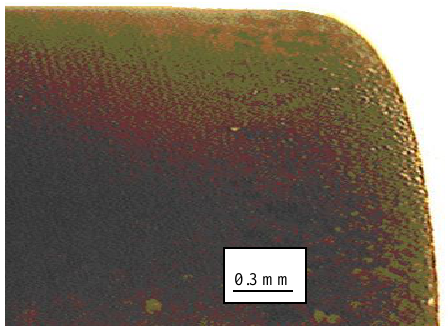
Figure 10. The profile of the graphite electrode after being used.